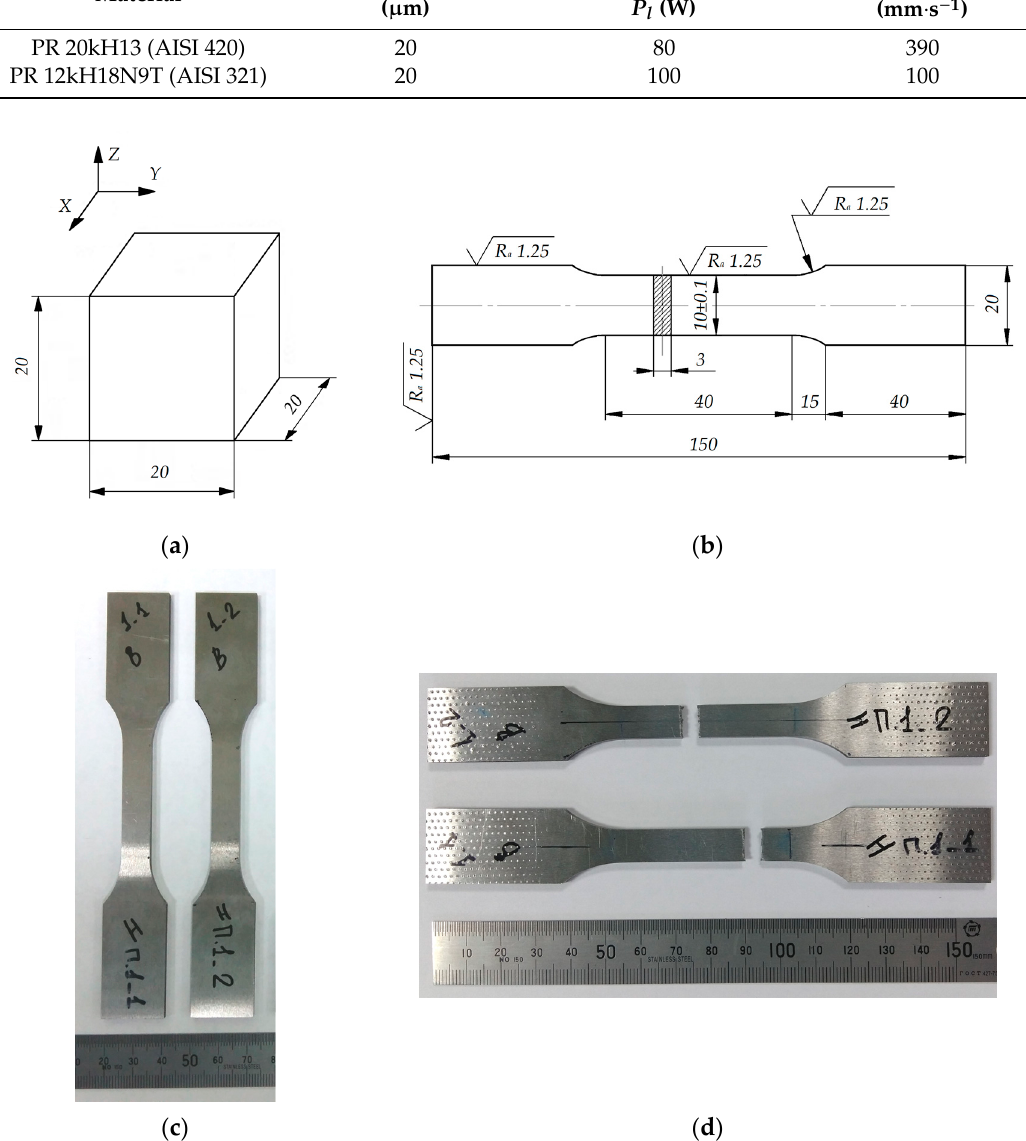
Figure 2. Specimens for tests: ( a ) schemes of specimens for hardness tests; ( b ) schemes of specimens for tensile tests; ( c ) general view of tensile test specimens; ( d ) destroyed specimens. Table 2. Laser powder bed fusion factors for growing solids. 10±0.1.